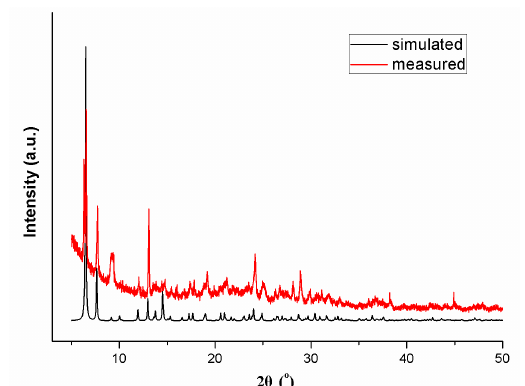
Figure 3. The simulated and measured powder X-ray diffraction (PXRD) patterns of 1 .